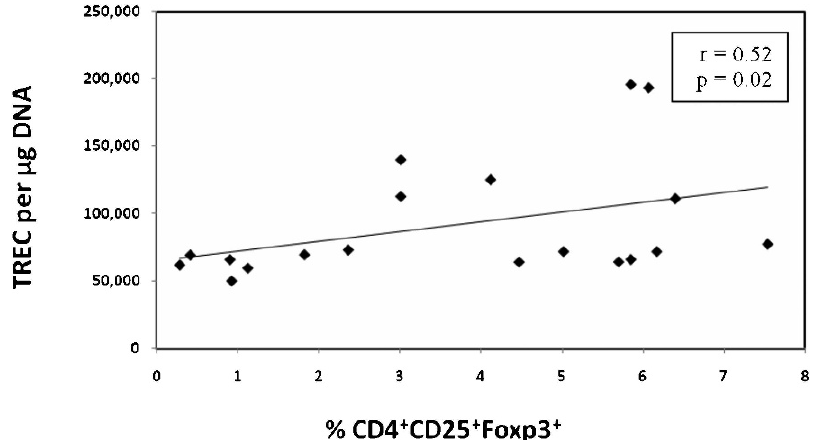
Figure 2 - Distribution of TREC levels per m g of DNA and CD4 + CD25 + Foxp3 + Treg cell levels. TREC levels per m g of DNA showed a positive correlation with the level of regulatory T cells (r=Spearman’s